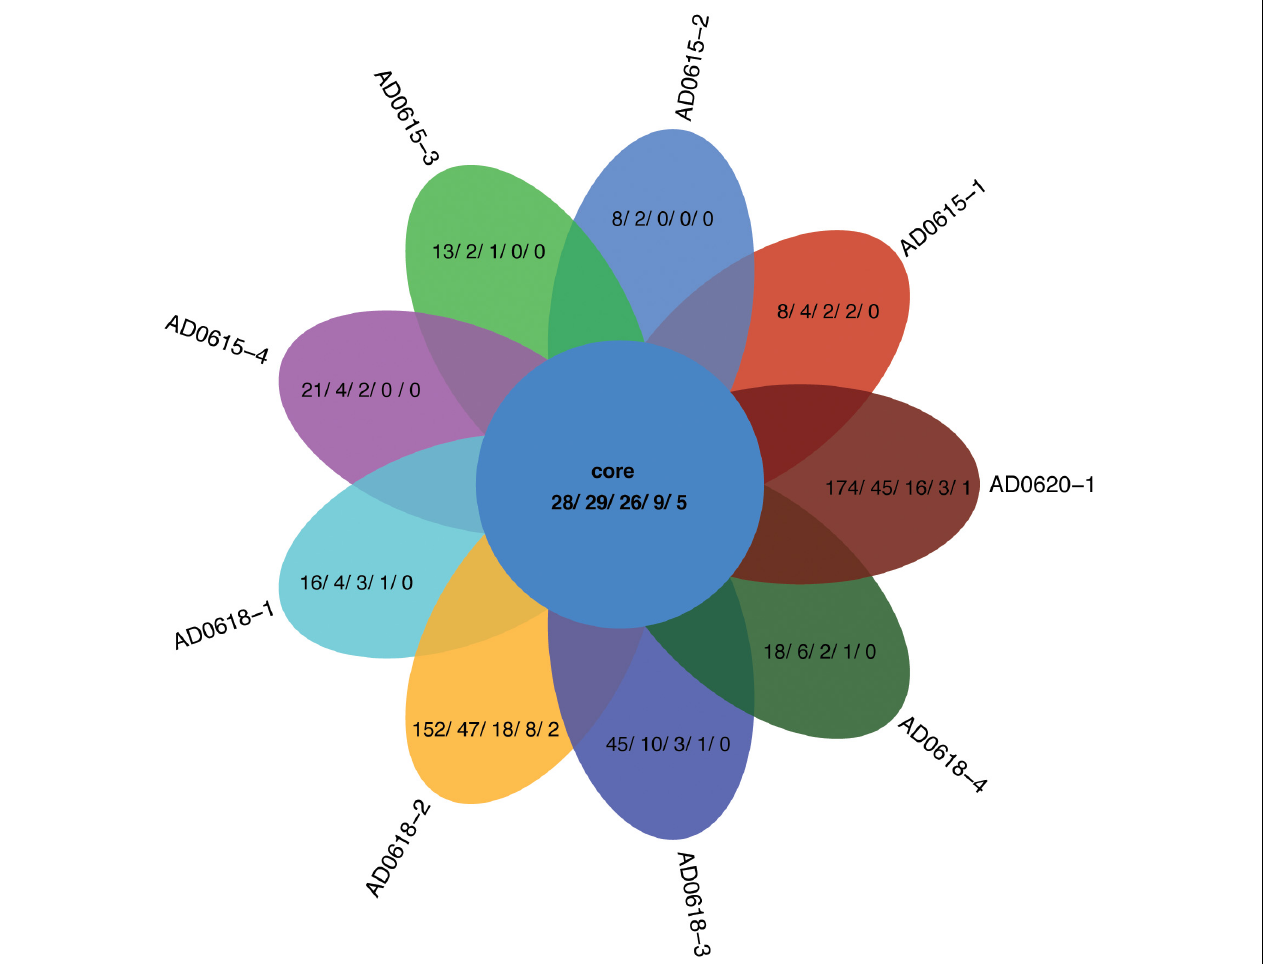
FIGURE 5 | Venn diagram showing the distribution contrast of the OTUs shared among all accessions and the unique OTUs per accession not shared with all other accessions. Numbers given represent the OTU/Phylum/Class/Order/Family, respectively.